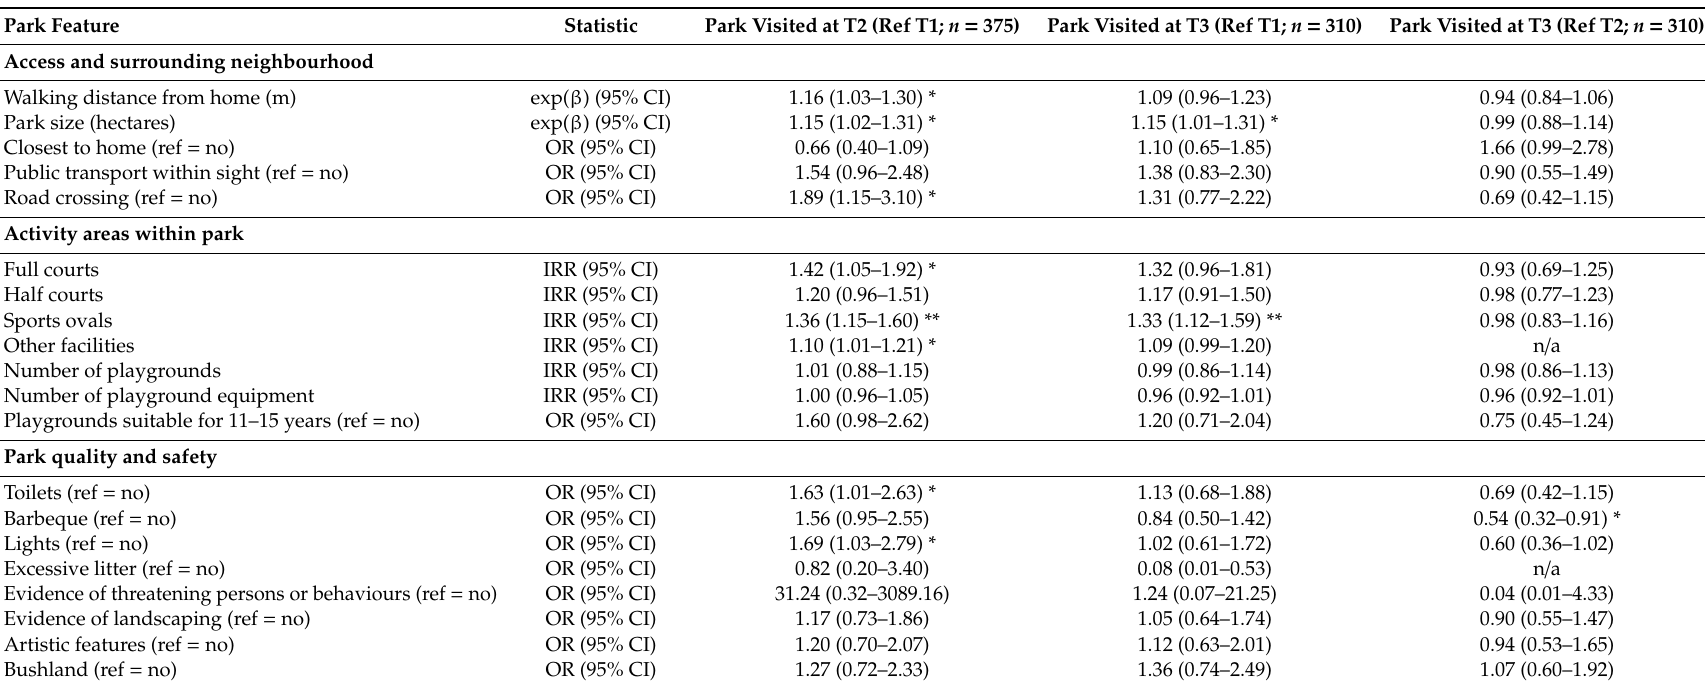
Table 2. Associations between park features of parks visited compared to previous